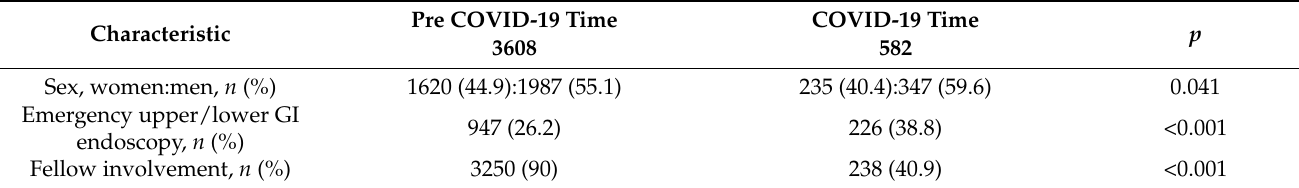
Table 1. General characteristics of endoscopic procedures performed before and during the COVID-19 period.